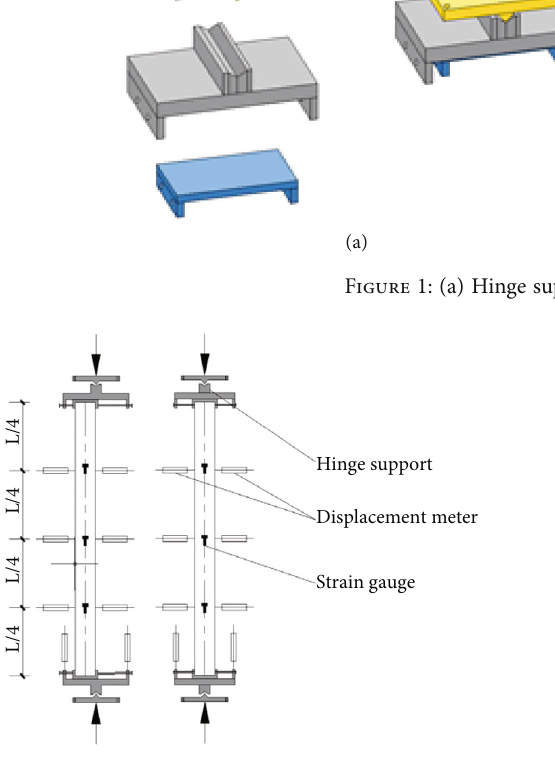
Figure 2: Schematic diagram of strain gauge arrangement and column